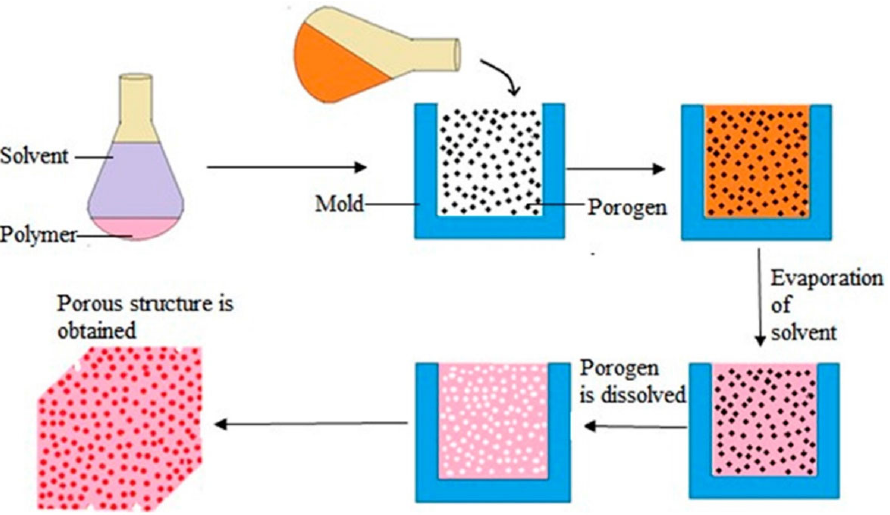
Figure 7. Overview of the solvent casting and particulate leaching process [161].